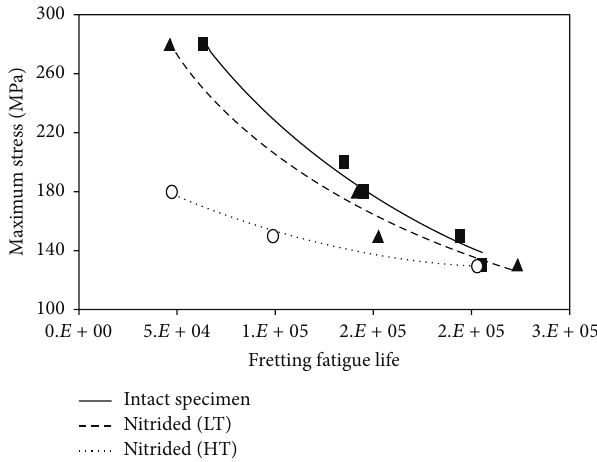
Figure 20: S-N curves for nitrided and normal specimens [22].